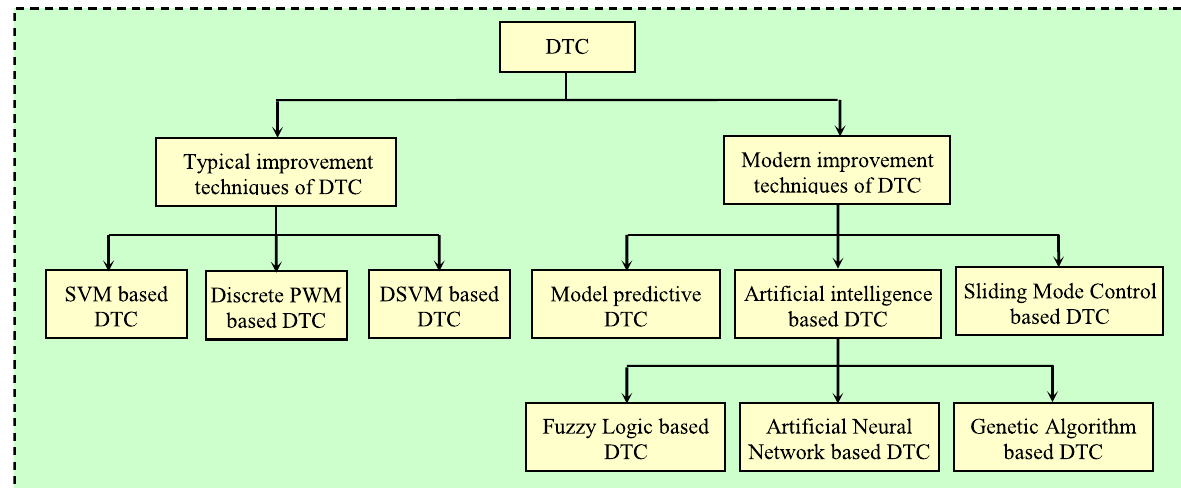
Fig. 2 Classification of improvement techniques of direct torque